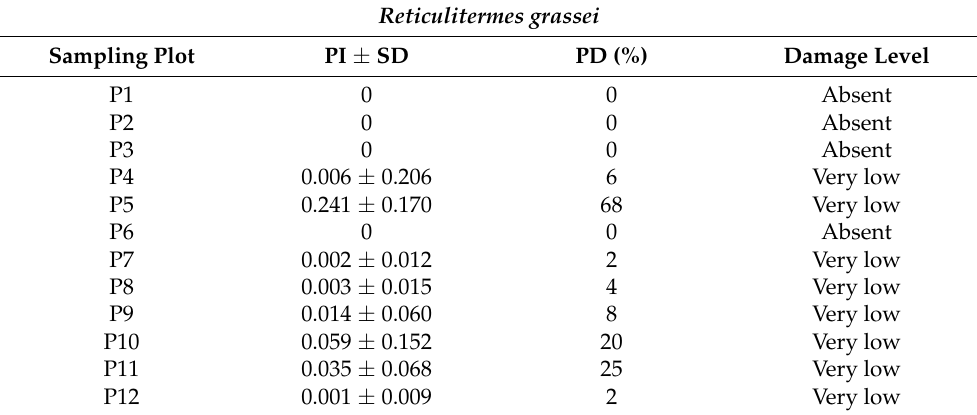
Table 5. Incidence of R. grassei referred to the plot infestation index (PI), the percentage of damaged cork oaks (PD) in relation to the total sampled trees and to the damage level obtained in each sampling plot (P). SD = standard deviation.